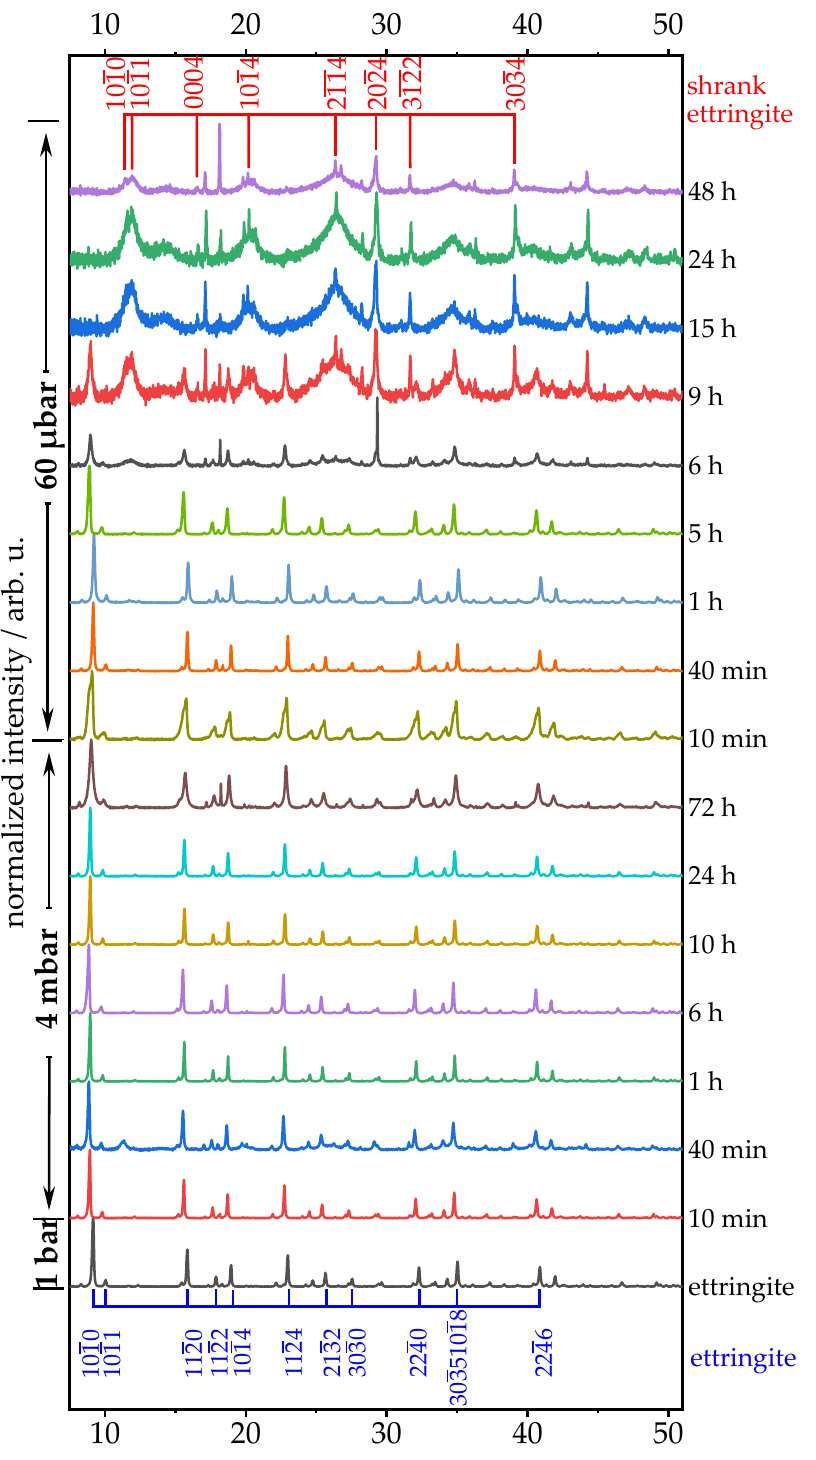
Figure 4. Identification of ettringite reflections (blue) and shrunk ettringite (red) in the diffraction pattern of synthetic ettringite; after treatment at two different levels of low pressure (4 mbar and 60 µbar) for various durations (up to 72 h), each treatment was performed on a different sample from the same batch. Bravais–Miller indices are given according to a trigonal symmetry in a hexagonal cell; full time frame depicted in Figure S6.